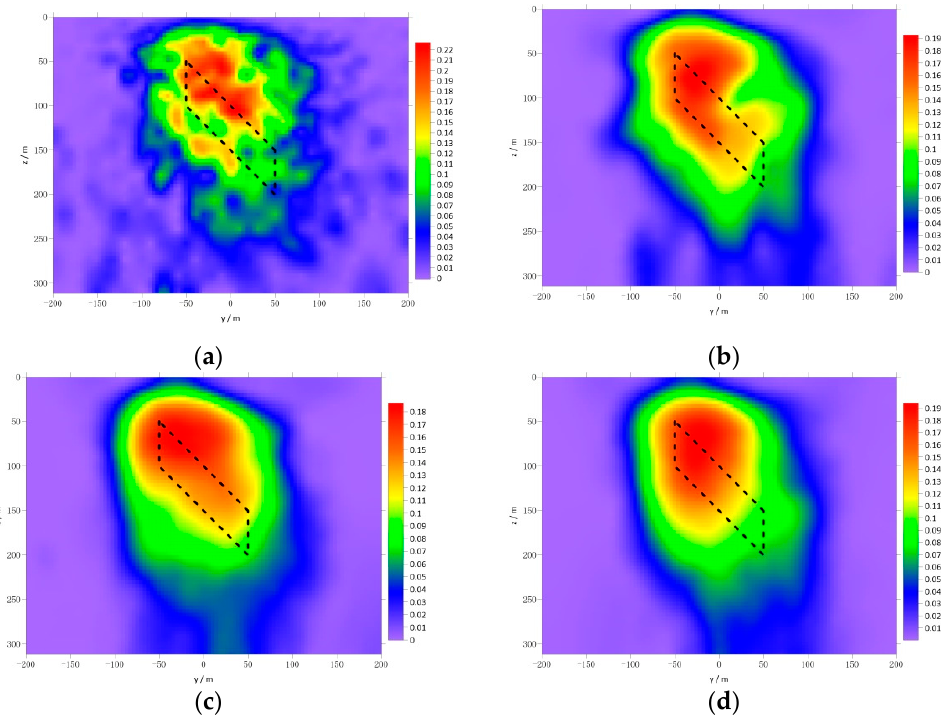
Figure 4. The inversion results of the model shown in Figure 2b with different 𝑠 (cid:3033) . ( a ) 𝑠 (cid:3033) = 0 , ( b ) 𝑠 (cid:3033) = 1 , ( c ) 𝑠 (cid:3033) = 2 , ( d ) 𝑠 (cid:3033) = 3 .